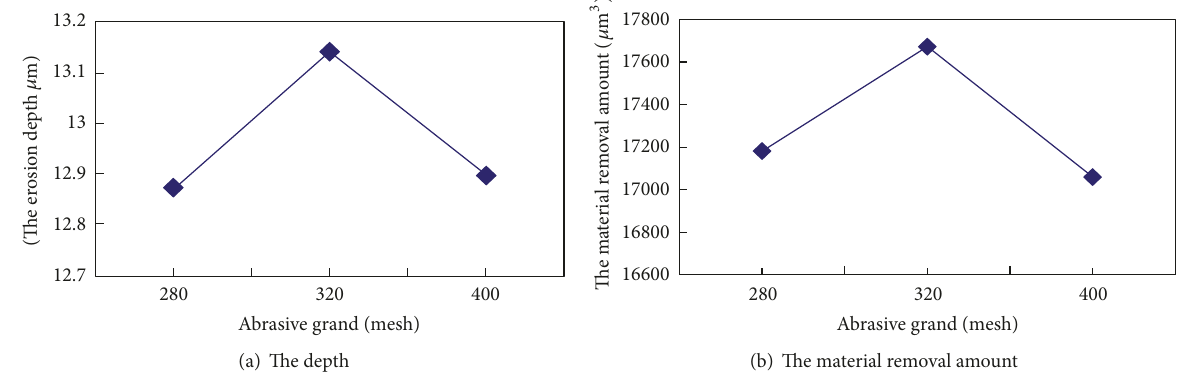
Figure 7: The influence of abrasive on the depth and the material removal